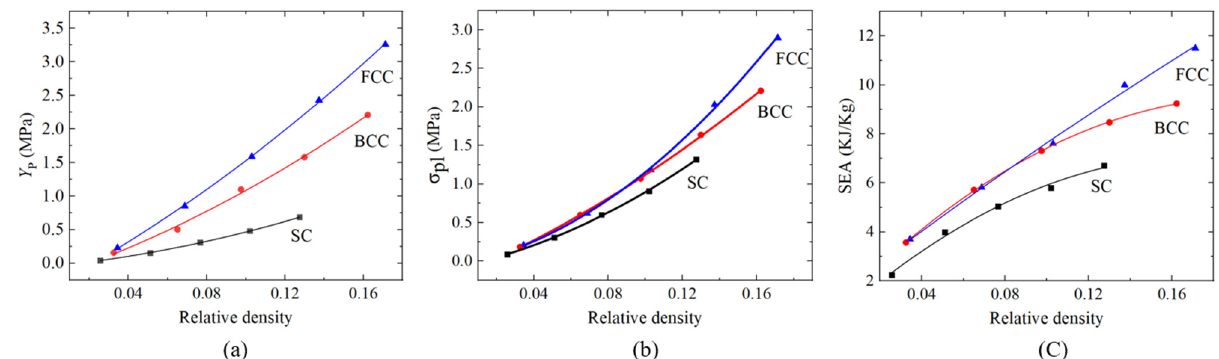
Figure 11. Effect of the relative density on the ( a ) first peak stress Y P , ( b ) plateau stress σ pl and ( c ) SEA for PHSSs in different arrangements.